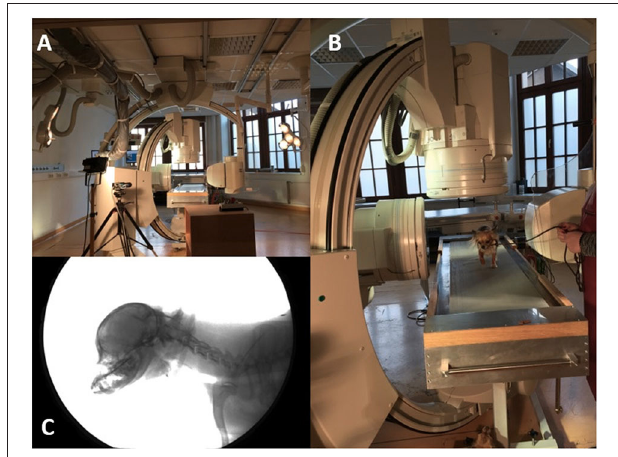
FIGURE 1 | Fluoroscopy 90 ◦ experimental setup. (A) : 90 ◦ fluoroscopy setting to record the-laterolateral and ventrodorsal beam path. The treadmill is located in the center. (B) : Chihuahua walking on the treadmill located in the beam path. (C) : X-ray video view of the laterolateral beam path.